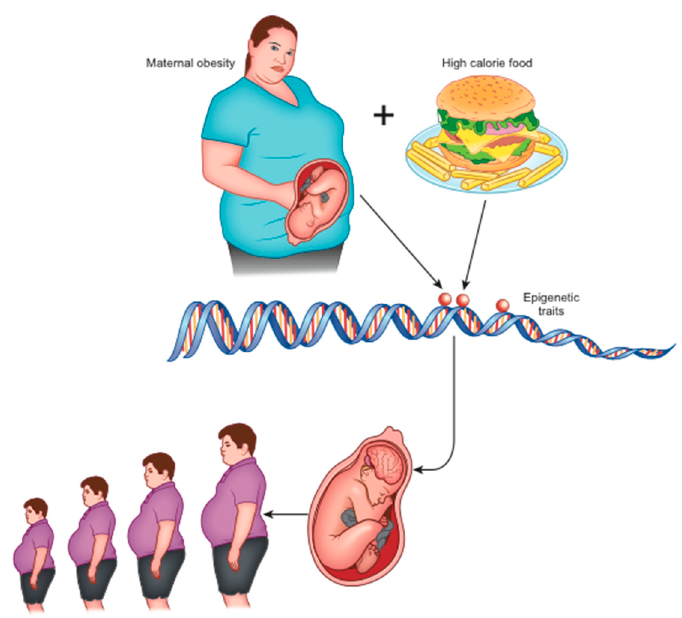
Figure 1. Maternal obesity and overeating at the origin of epigenetic changes that lead to neurologic-based generational predisposition to obesity.